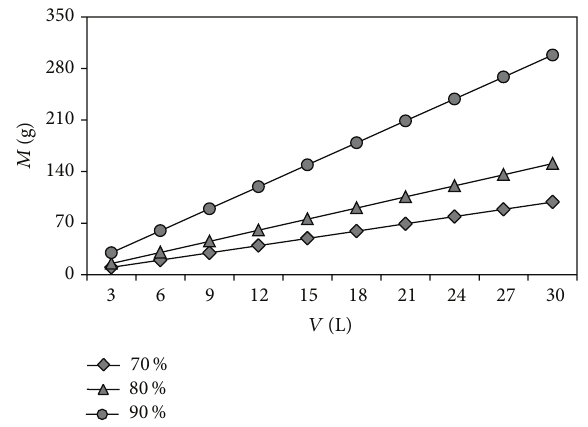
Figure 8: Required biosorbent amount ( 𝑀 ) versus volume of dye solution treated ( 𝑉